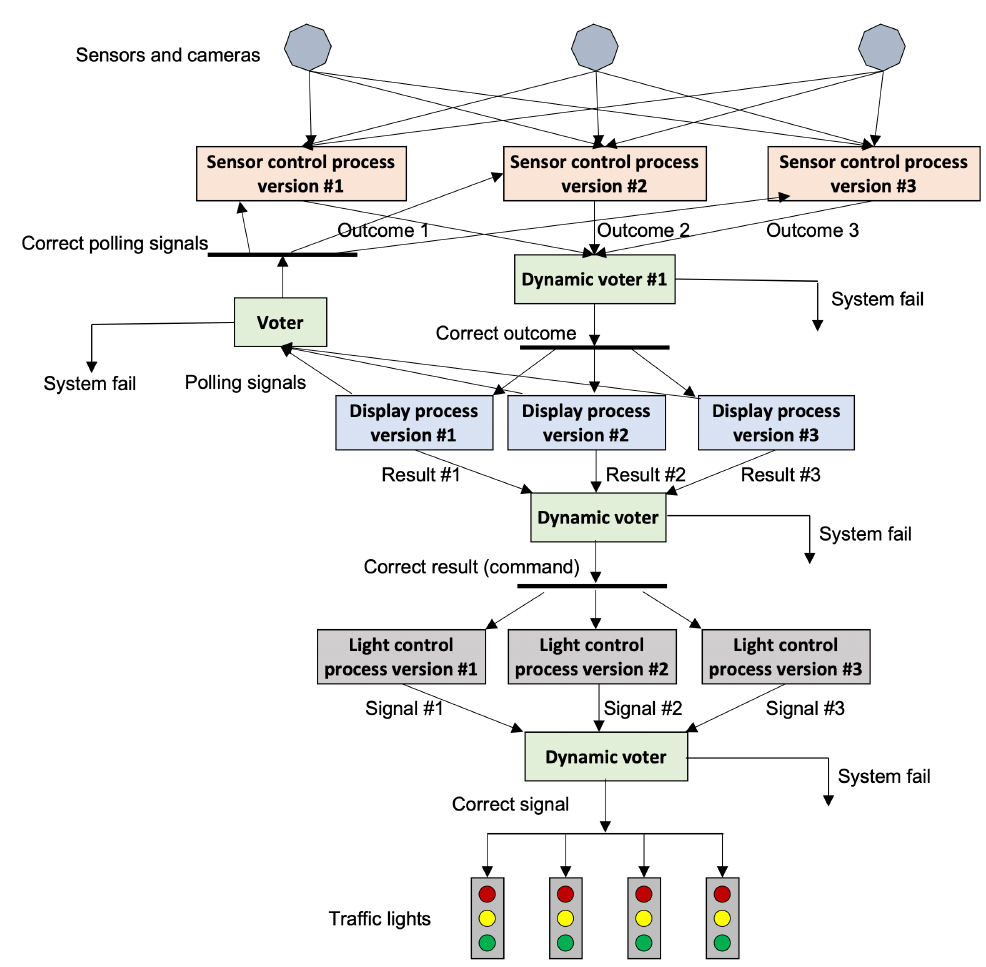
Figure 3. Resilient multiprocessor traffic control